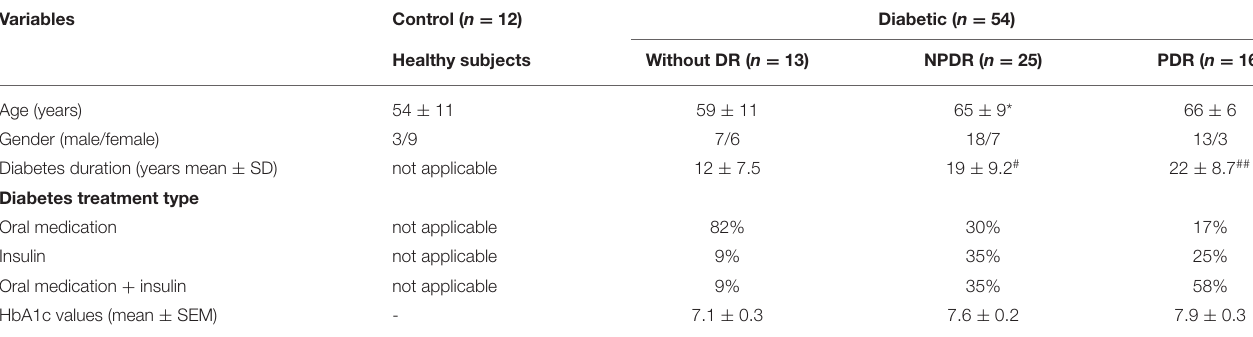
FIGURE 1 | (A,B) Tear function tests in healthy, nondiabetic controls and T2D patients without DR or with NPDR or PDR. (A) Schirmer test I showing significantly reduced scores in diabetics compared to controls (Kruskal-Wallis test). (B) Above 60% of diabetics have < 10 mm/5min of tears volume, suggesting impairment of tears secretion or production. (C) Tear break-up time (TBUT) showing significantly decreased (One-way ANOVA) values in NPDR and PDR subjects, reflecting changes in tear stability in DR. Values are expressed as mean ± S.D. * p < 0.05, ** p < 0.001 vs. CTRL. CTRL, healthy, nondiabetic control; T2D, type 2 diabetes; NPDR, nonproliferative DR; PDR, proliferative DR.